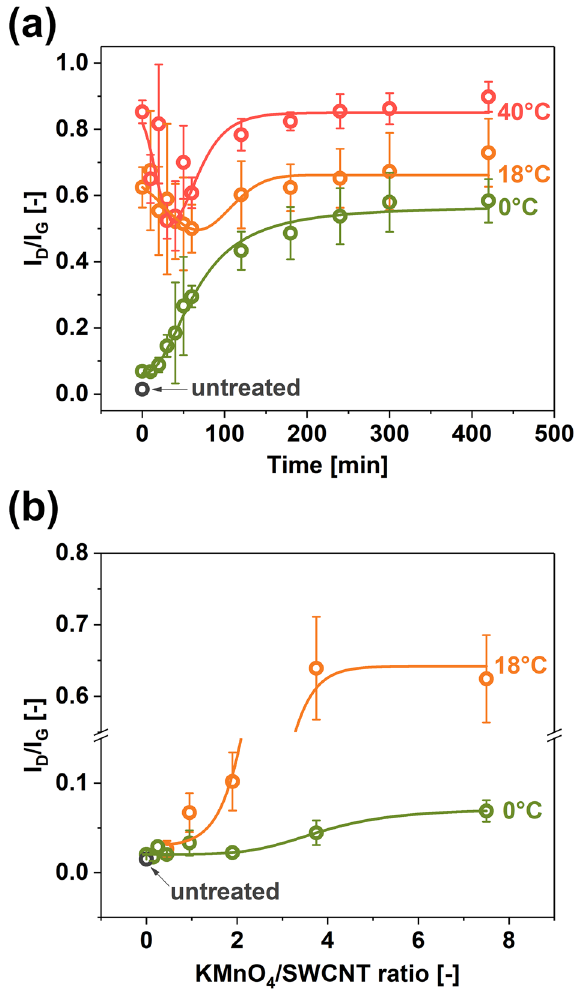
Figure 1. The impact of SWCNT oxidation on the I D /I G ratios of the obtained products determined by Raman spectroscopy as a function of (a) time (KMnO 4 /SWCNTs = 7.5), (b) KMnO 4 /SWCNT ratio (t = 0